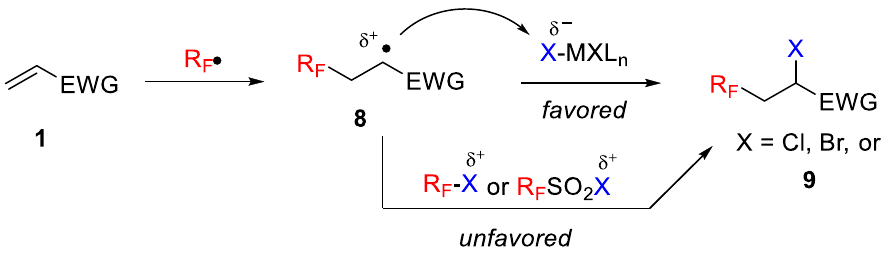
Scheme 8. ATRA reaction of the fluoroalkyl radical with electron-deficient alkenes.